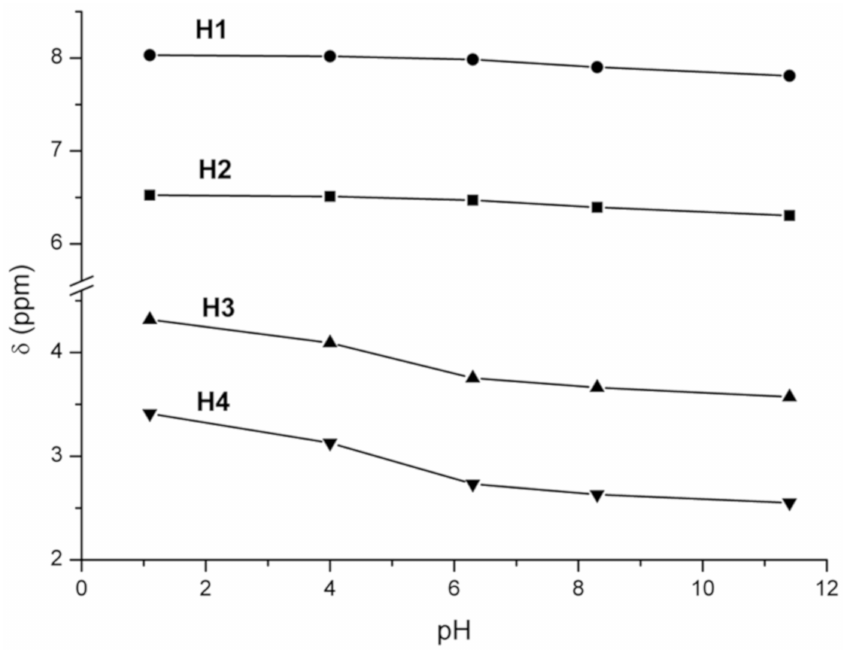
Figure 3. 1 H–NMR chemical shift of L1 in an aqueous solution as a function of pH. Analyzing L1 (Figure 3), starting from alkaline pH and considering the pH range 11.5–8.5, where − − the H − 2 L1 2 and H − 1 L1 species are present in solution, the aliphatic signals (H3, H4) show a